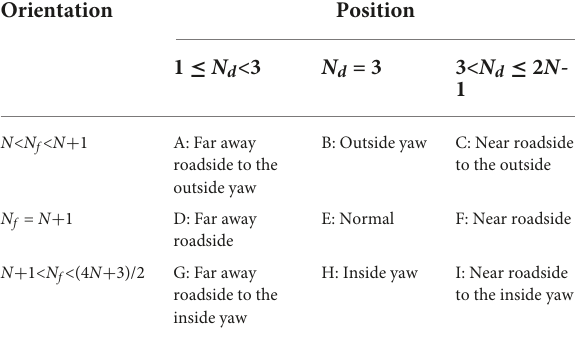
TABLE 1 Generalized position and orientation state classification rules for unknown number of photoelectric switches.